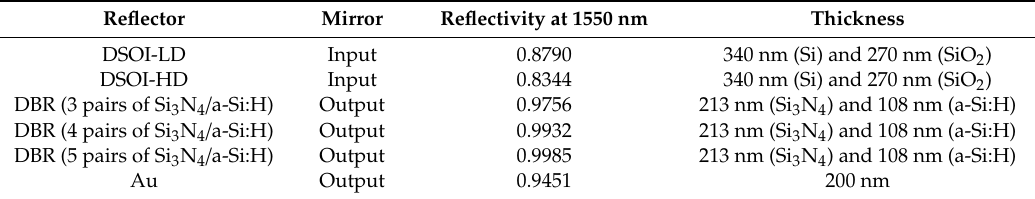
Table 1. Reflectivity and thicknesses of all investigated